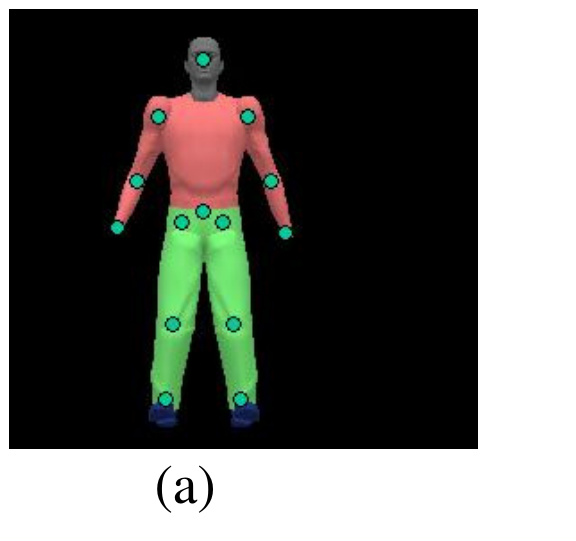
Figure 3. Model marker points (a) from key-point detection; (b) from dense ICP correspondences (each yellow vector represents a correspondence